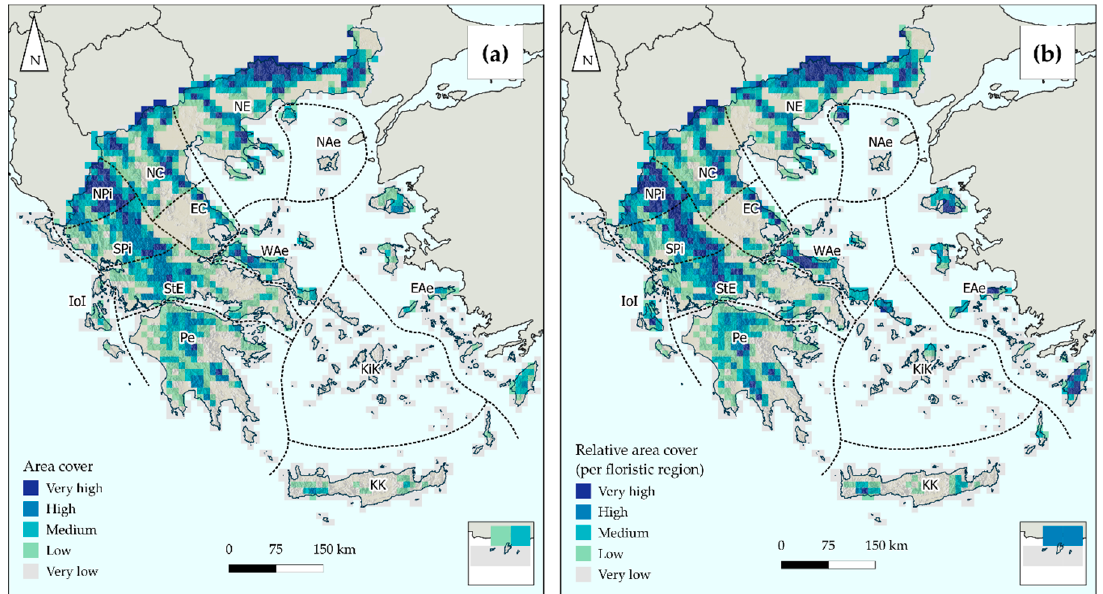
Figure 3. Thematic representation for ‘woodland and forest’ ecosystem type extent at the 10 × 10 EEA